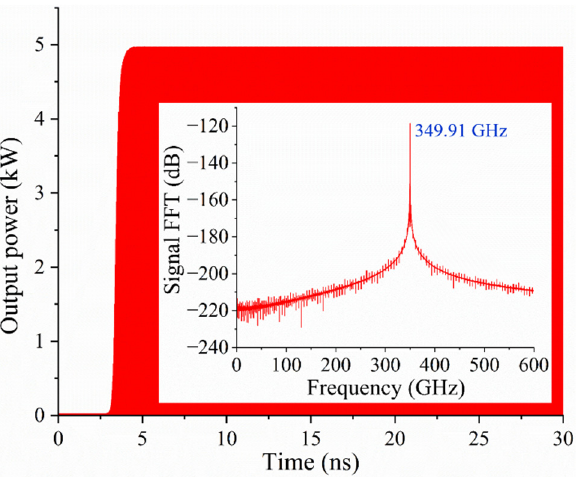
Figure 7. Time-dependent output power and corresponding frequency spectrum.